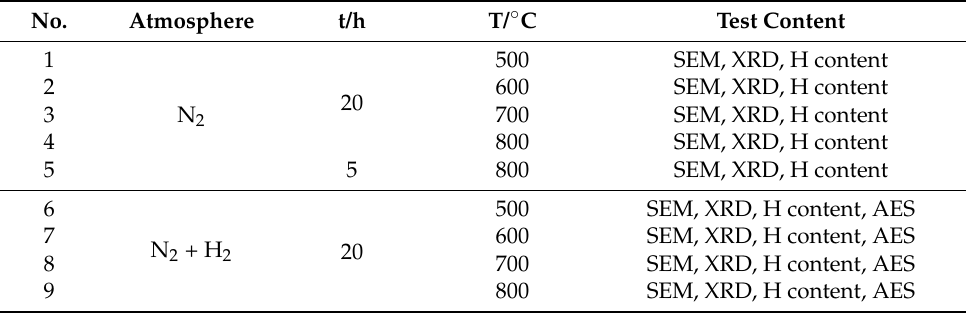
Table 1. The experimental scheme for the preparation of hydrogen permeation barrier on zirco- nium